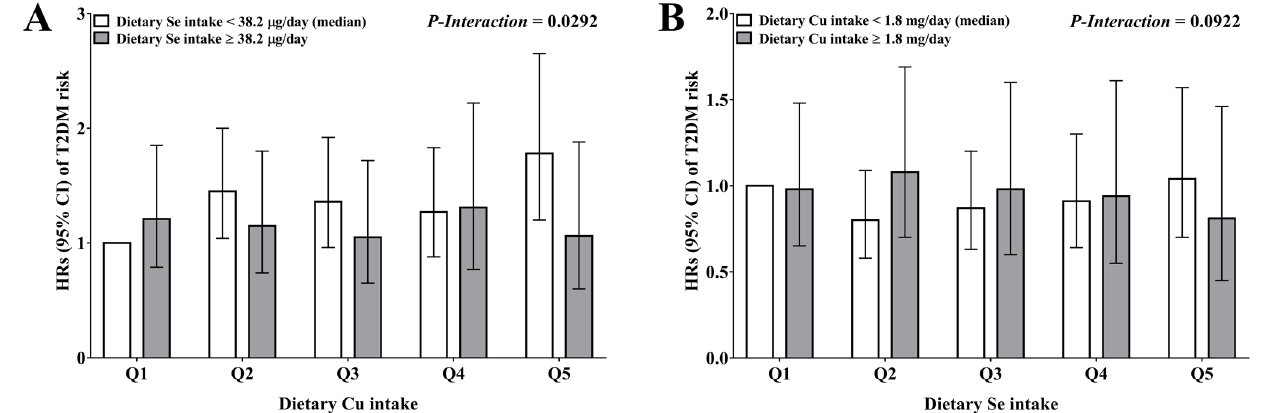
Figure 2. Joint analysis of dietary Cu and Se intake on T2DM risk. ( A ) The joint analysis of dietary Cu (quintiles) and Se (median) on T2DM risk. ( B ) The joint analysis of dietary Se (quintiles) and Cu (median) on T2DM risk. Data was presented as HR (95% CI) estimated by using time-dependent Cox proportional hazard regression models. Models adjusted for sex (women or men), age (<50, 50–54, 55–59, 60–64 or ≥ 65 years), BMI (<18.5, 18.5–23.9, 24–27.9 or ≥ 28 kg/m 2 ), urban index (tertiles), region [north (Beijing, Liaoning, Heilongjiang, Shandong, and Henan) or south (Shanghai, Jiangsu, Hubei, Hunan, Guangxi, Guizhou, and Chongqing)], education level (primary school, middle school, or high school), alcohol intake (ever drinking or not), smoking (ever smoking or not), physical activity (tertiles), baseline hypertension (yes or no), and dietary variables, including total energy intake, dietary GI, fiber intake, animal to plant protein ratio, PUFA to SFA ratio, and cholesterol intake (all quintiles). Abbreviations: Cu, copper; GI, glycemic index; PUFA, polyunsaturated fatty acid; Q, quintiles; Se, Selenium; SFA, saturated fatty acid; T2DM, type 2 diabetes